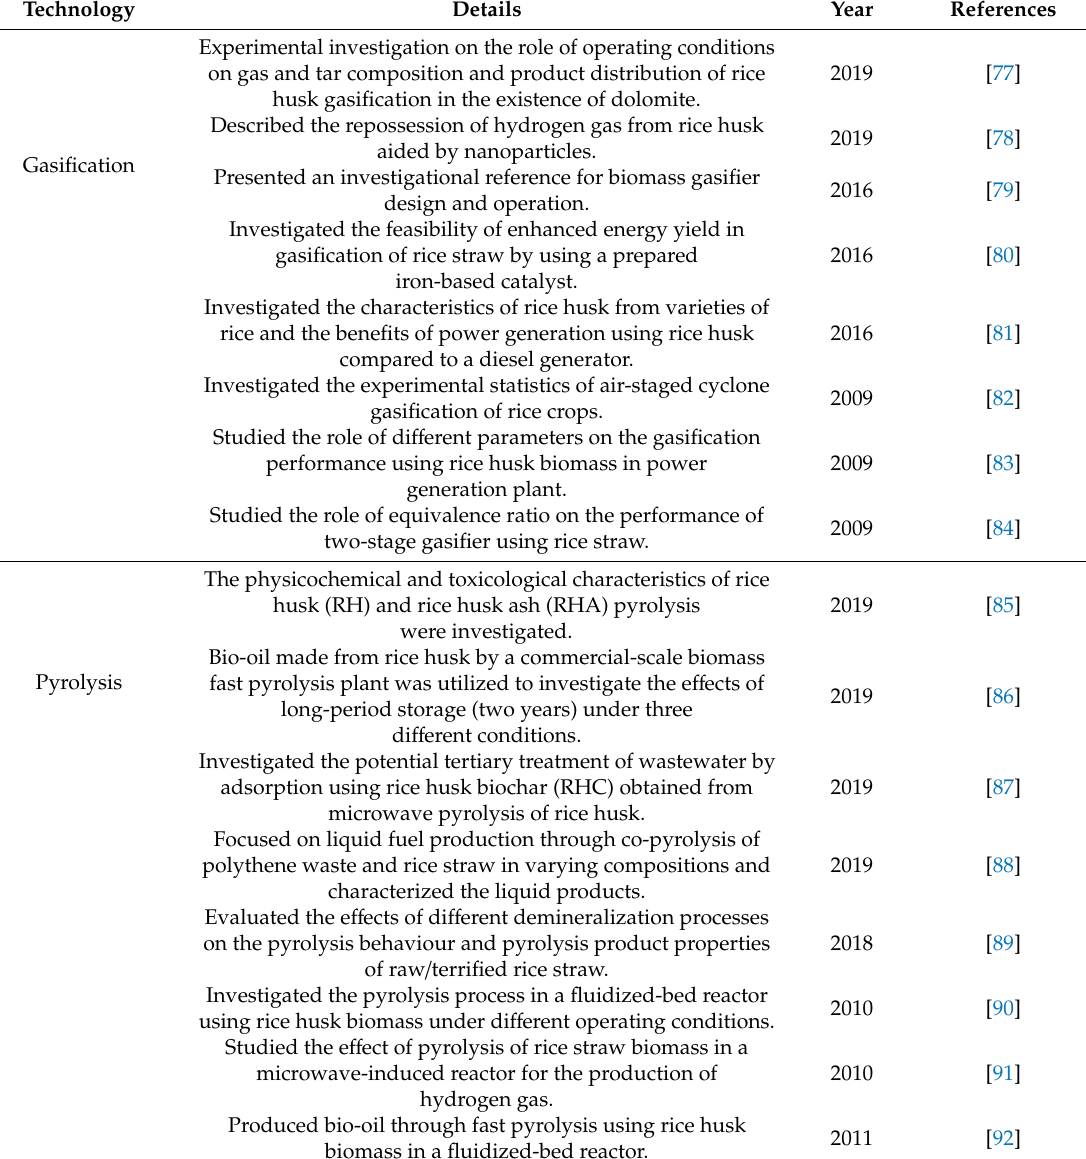
Table 3. Summary of recent research in agricultural